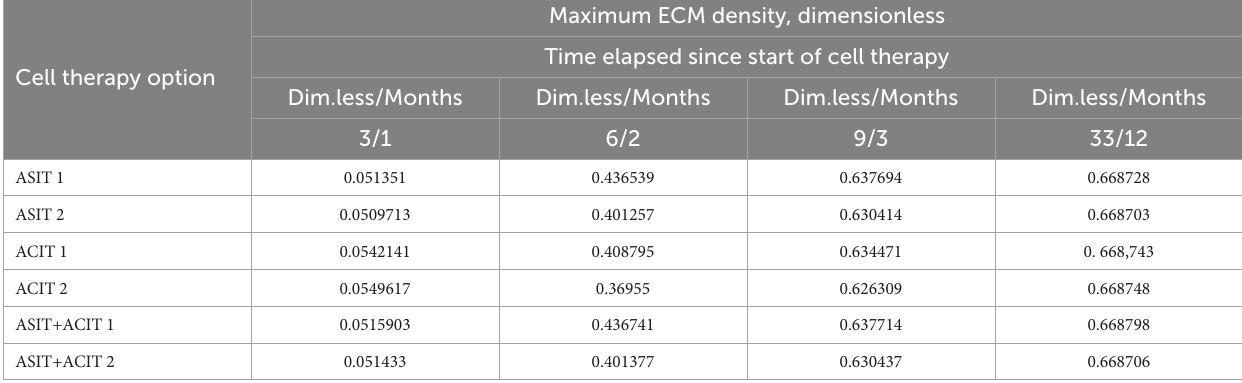
TABLE 2 Maximum values of ECM density at different time points with different cell therapy options under conditions of tissue mechanical stimulation in the area of the defect.